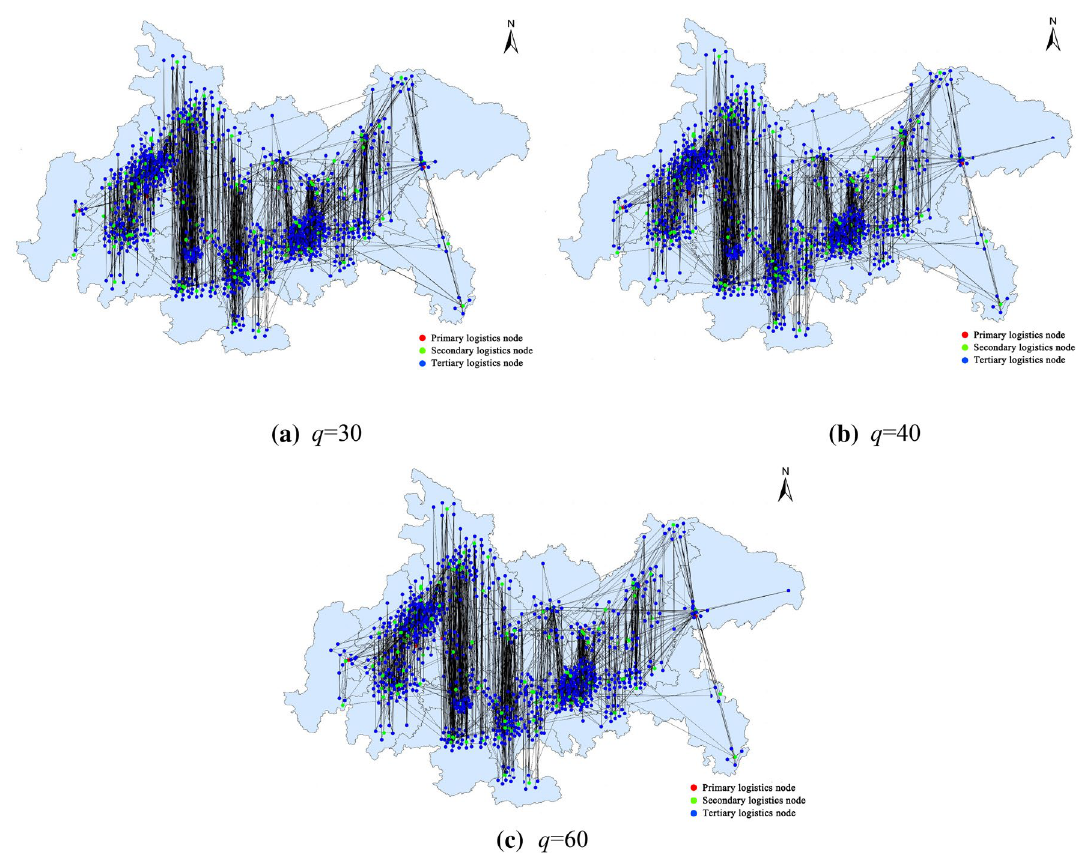
Fig. 7 The influence of parameter q on network evolution Table 4 Characteristic parameters of the final evolution network with different values of q